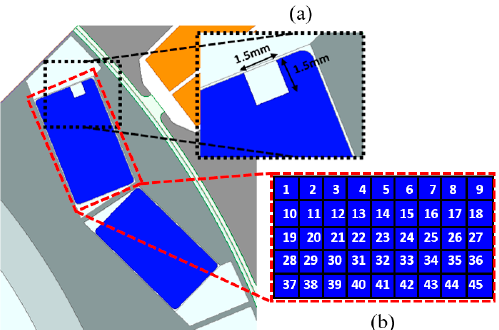
Figure 9. Irreversible demagnetization contribution depending on magnet position: ( a ) Assumed irreversible demagnetization region, ( b ) Magnet position.